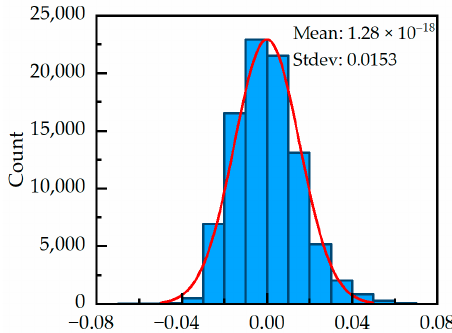
Figure 5. Histogram of the differences between the regression and real values of the reflectance of snow cover in the SWIR band.